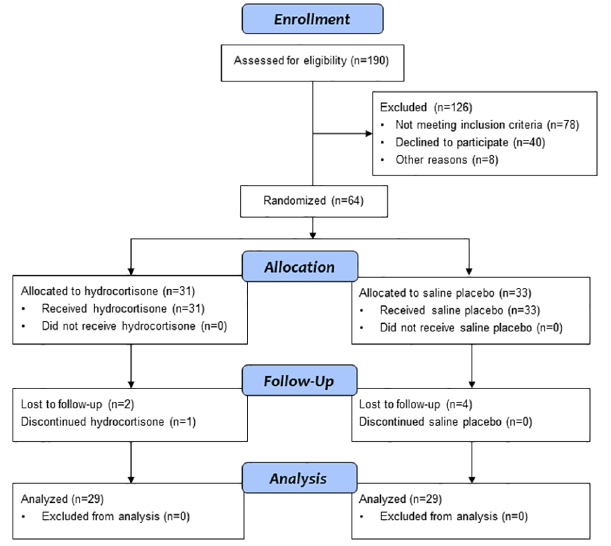
Fig 1. Stress Dose Hydrocortisone Trial Flow Diagram. Flow of study participants from study enrollment to 18 to 22 months corrected age follow-up.